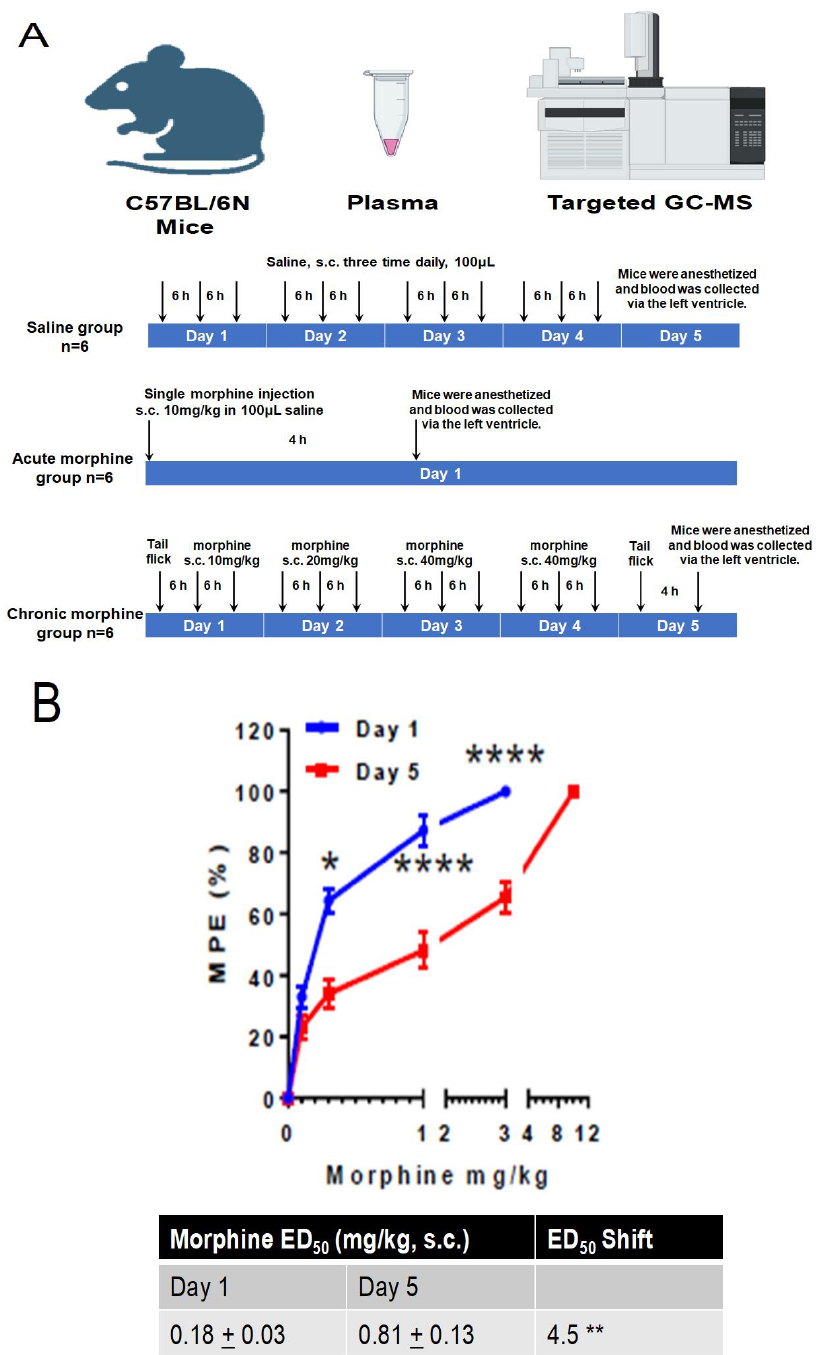
Figure 1. Schematization of study design and morphine-tolerance mice model development. ( A ) Schematic depicting morphine dosing and behavioral testing paradigm for morphine-induced tolerance experiments. ( B ) Dose–response curve of morphine in C57BL/6N mice. Cumulative dose–response studies were performed before (Day 1) and after (Day 5) morphine treatment. Error bars represent SEM from 6 mice. * p , 0.05 , ** p , 0.001 and **** p , 0.0001 for an unpaired Student’s t test.